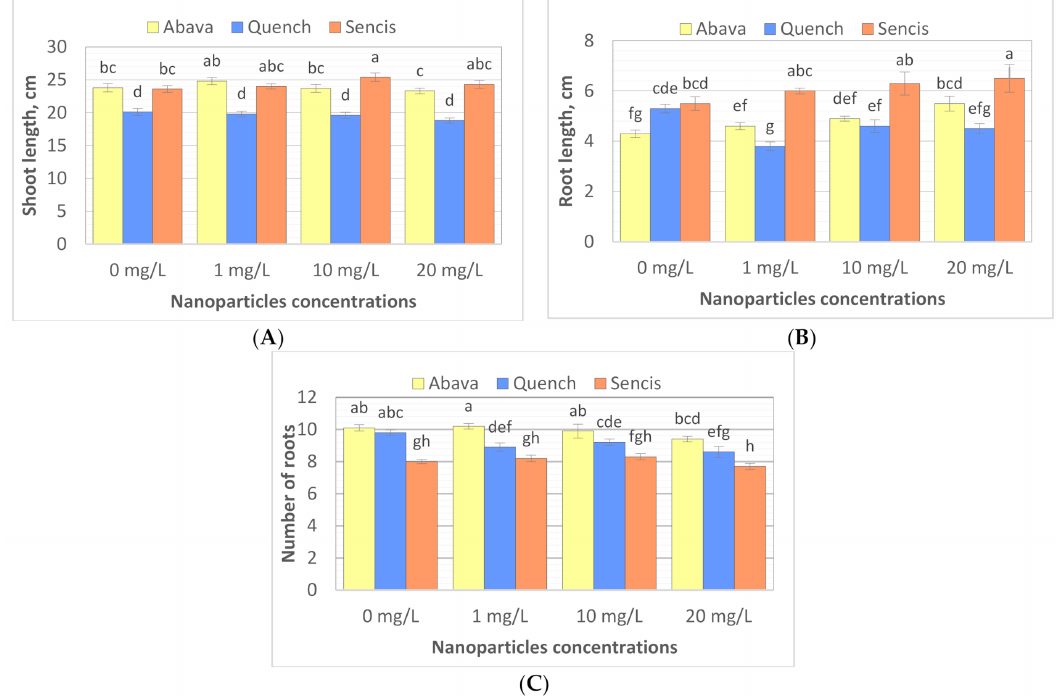
Figure 3. Shoot length ( A ), root length ( B ), number of seminal roots ( C ) expressed as the % of control, in H. vulgare L. cultivars seedlings grown 8 days with 1, 10, and 20 mg/L of Fe 3 O 4 NPs. Values are the mean of three replicates with SD. Different letters within each bar indicate significant differences at p < 0.05 and the same letters indicate no significant difference (Tukey’s test—two-way analysis of